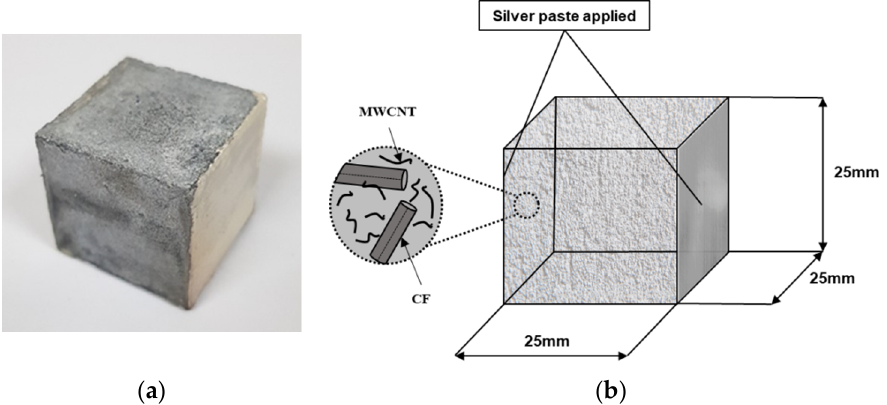
Figure 1. ( a ) Image of the alkali-activated slag (AAS) composite used in this study and ( b ) layout of the AAS composite specimen containing both multi-walled carbon nanotubes (MWCNTs) and carbon fibers